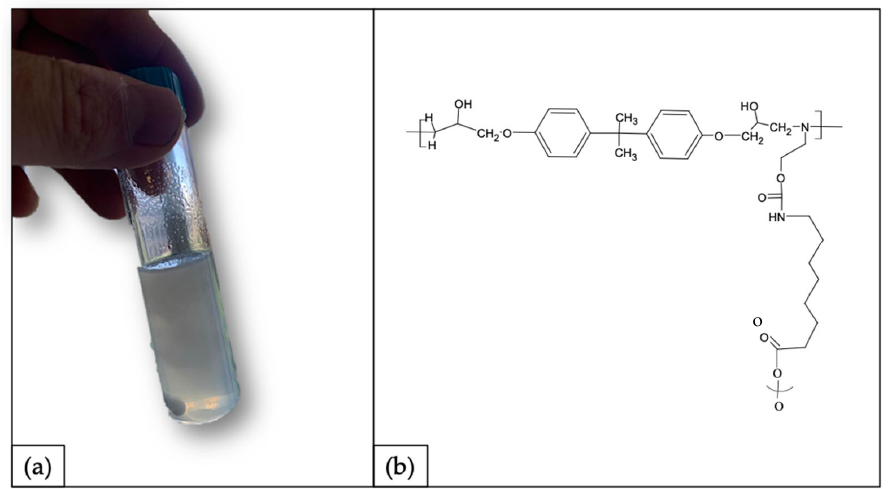
Figure 11. ( a ) Synthetized polyurethane as re-use strategy: proof of concept and ( b ) hypothesized chemical structure for the synthetized polyurethane.